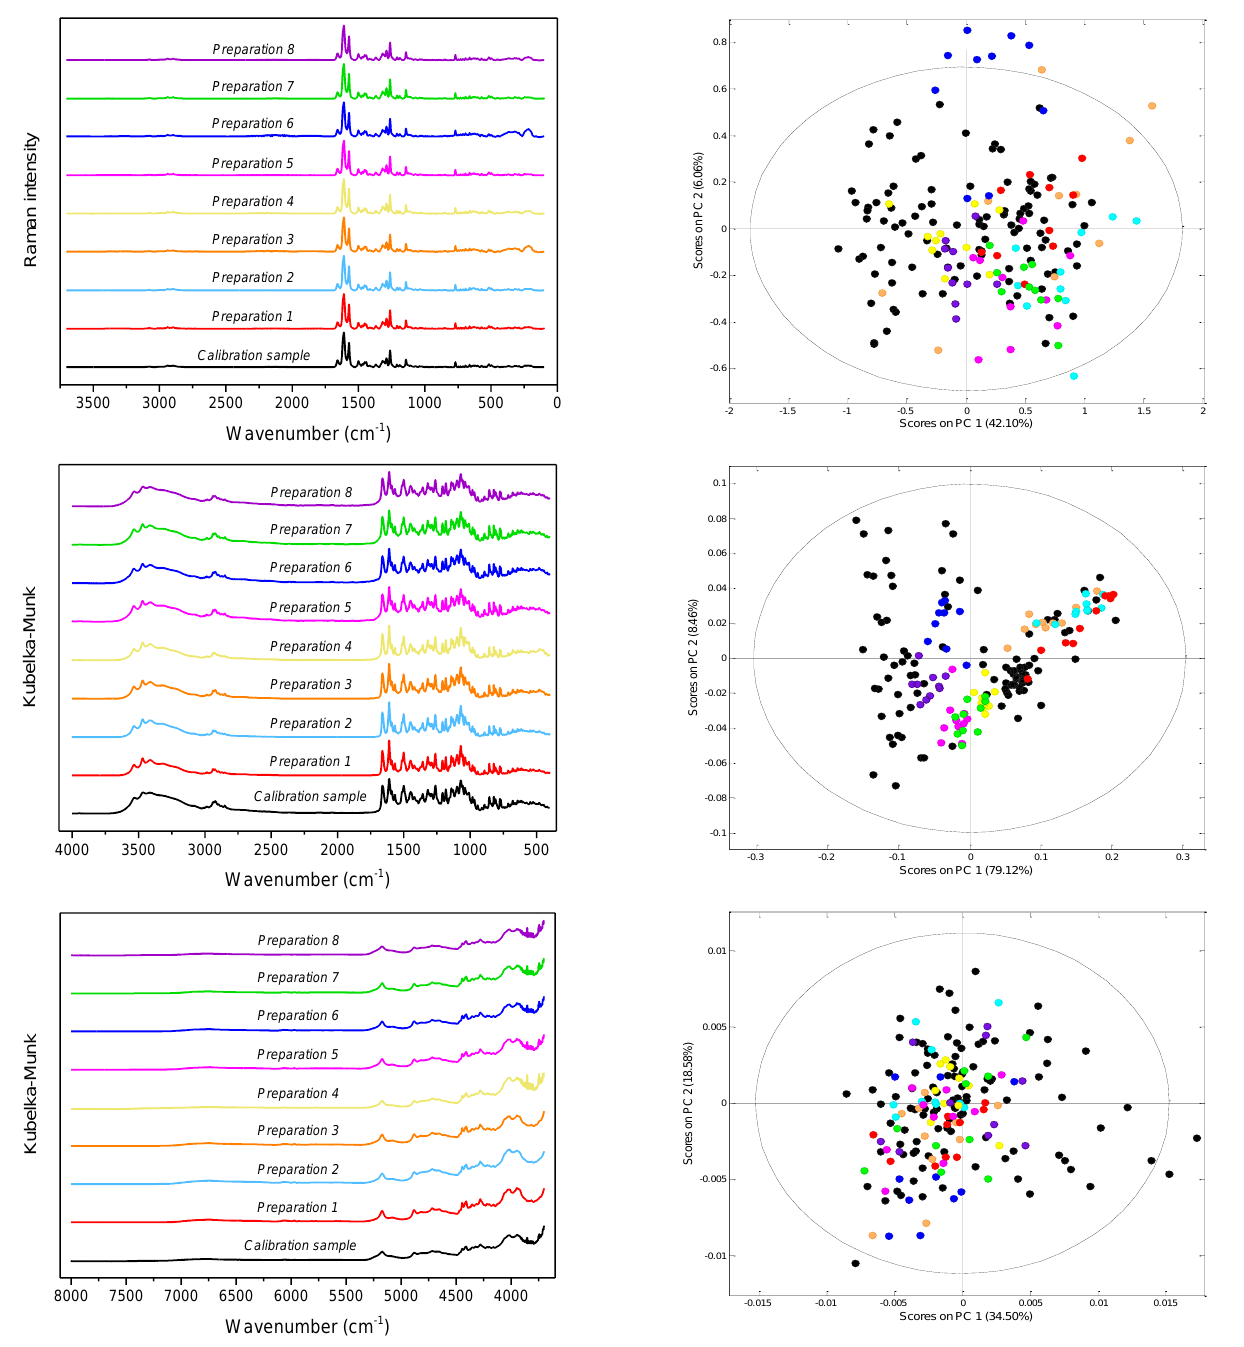
Figure 3. From the top: Raman, MIR and NIR spectra ( left ) of the studied preparations and distribu- tion of samples in the PC1/PC2 space with the 99% confidence interval ( right ); black dots—calibration mixtures, colored dots—pharmaceutical